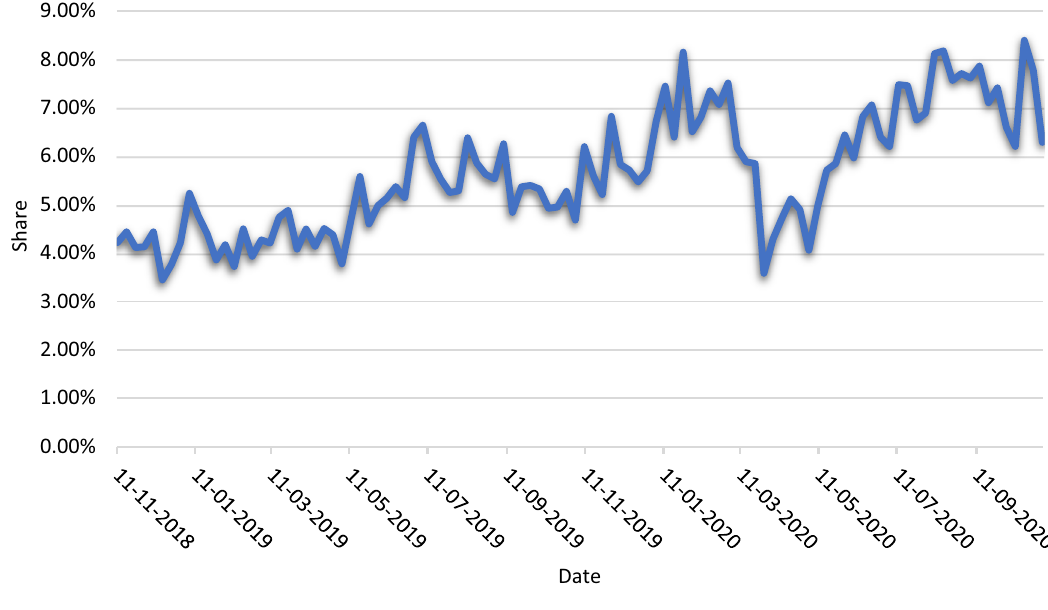
Figure 1. Plant-based meat alternative share of total expenditures on ground meat